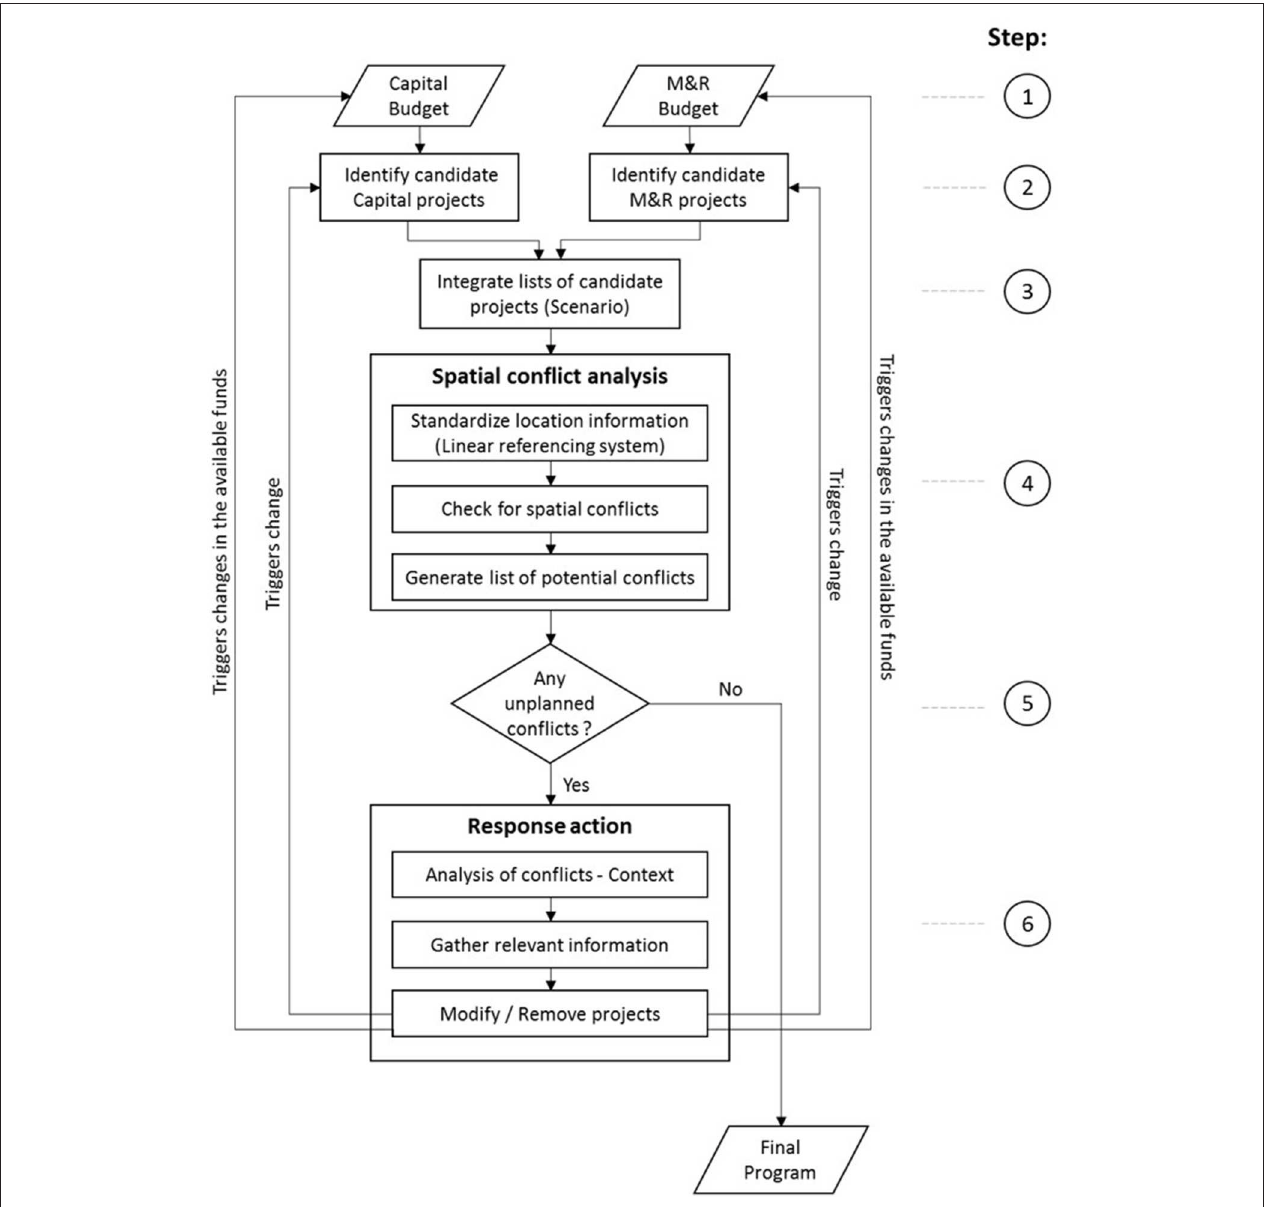
FIGURE 3 | Integrated framework for cross-functional planning of highway